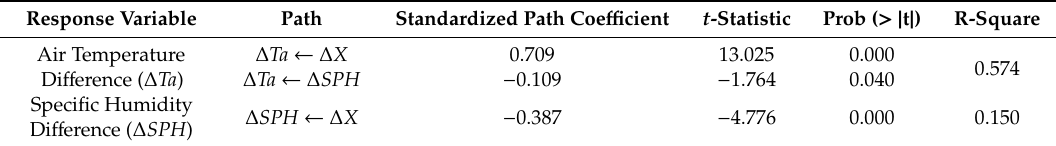
Table 3. Path analysis results of priori model